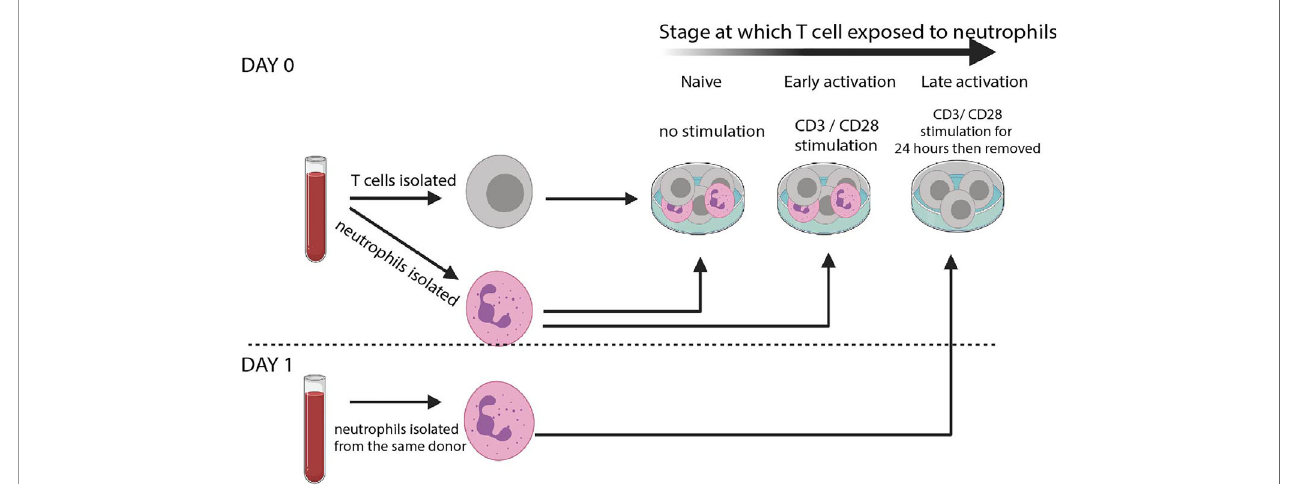
FIGURE 1 | T cell – neutrophil co-culture system. Schematic of culture system. Rapid isolation of peripheral blood neutrophils by negative magnetic selection is performed before autologous T cells are isolated. Cells are co-cultured at a 5: 1 Neutrophil: T cell ratio either without any stimulation ( ‘ naïve ’ ) or in the presence of CD3/CD28 stimulating activation cocktail ( ‘ early ’ ). T cells are also cultured alone in the presence of a CD3 a CD28-coated Dynabeads. 24 hours later Dynabeads are removed and fresh autologous neutrophils isolated. These are co-cultured without any further stimulation ( ‘ late ’